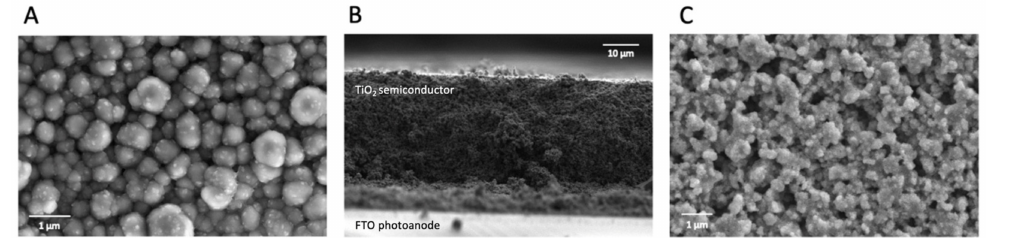
Figure 3. Surface characteristics of photoanodes and counter electrodes. SEM micrographs of ( A ) PEDOT/CNT ( B ) cross-section view and ( C ) top view of sintered TiO 2 all on FTO.